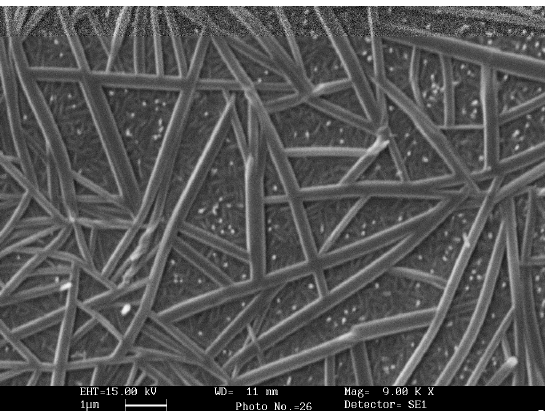
Figure 5 . Scanning electron micrograph of thin film of CoPc on to the glass substrates deposited at 458K Table 3 . Variation of grain size with substrate temperatures for CoPc thin film Substrate temperature, K Grain length, nm Grain breadth, nm 303 246 363 5670